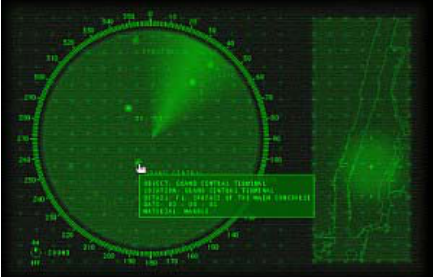
Fig. 1: The outlook of the interface. H. Minami, Infrasonic Soundscape , http://www.dedalu.art.br/artigos/200503imgs/infrasonic.jpg, retrieved: 10. 10.